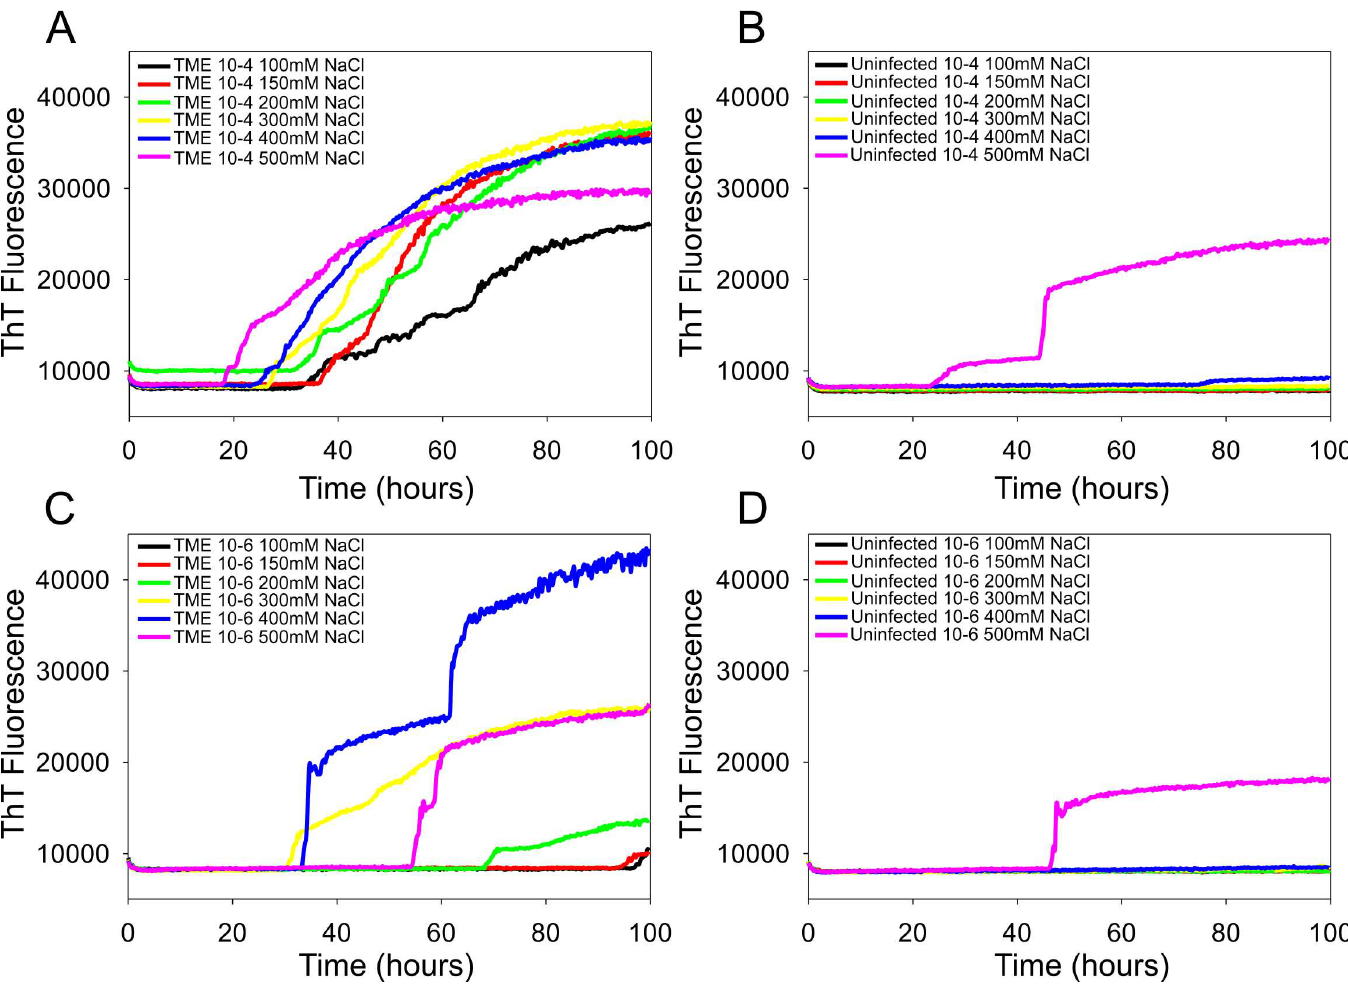
Fig 3. RT-QuIC sodium chloride titration for TME-infected and uninfected cattle brain samples. RT-QuIC reactions were seeded with 10 − 4 (A, B) and 10 − 6 dilution(C, D) of TME-infected and uninfectedcattle brain homogenates using a range of NaCl concentrations (100–500mM) with the full-lengthbPrP E211K protein (aa 25–241)as substrate. Data are presented as mean ThT fluorescence of 8 reactions conductedas 2 repeats of 4 reactions. The positive thresholdwas calculateas ~10,000relative fluorescence units of normal cattle brain